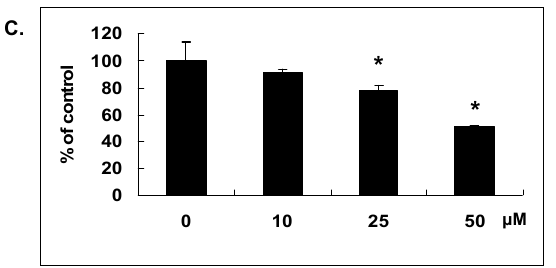
Figure 2. Gallic acid reduced matrix metalloproteinase-1 (MMP-1) expression . NPC-BM1 cells were treated with gallic acid for 24 h and the expressions of MMP-1 related to the mRNA ( A ); protein in cytosol ( B ) and conditioned medium; ( C ) were measured by qRT–PCR, Western blot and ELISA analysis respectively. The gallic acid dose-dependently decreased MMP-1 gene and protein expressions in NPC-BM1 cells. Delta Rn (dRn) indicated the magnitude of fluorescence signal generated during the PCR at each time point. Data were representative results from experiments repeated at least three times. * p < 0.05 versus vehicle control.